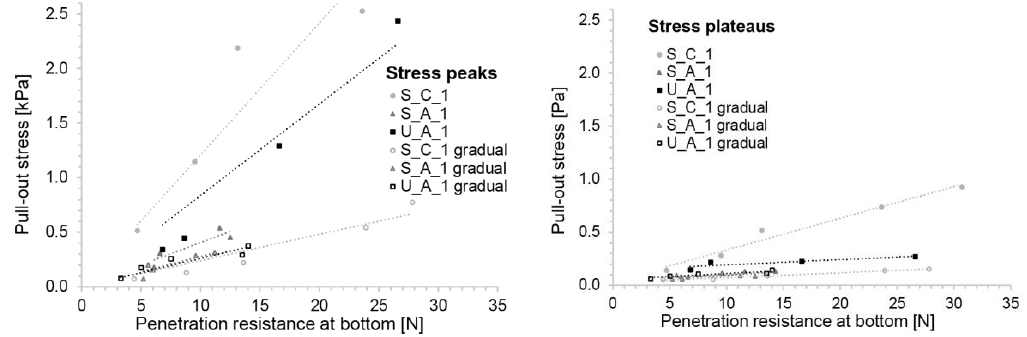
Figure 11. Relation of pull-out stresses to penetration resistance of the material at the bottom of the friction box. ( Left ) Peak pull-out stress, ( right ) plateau pull-out stress. Both graphs show the three concrete compositions and the two filling modes.